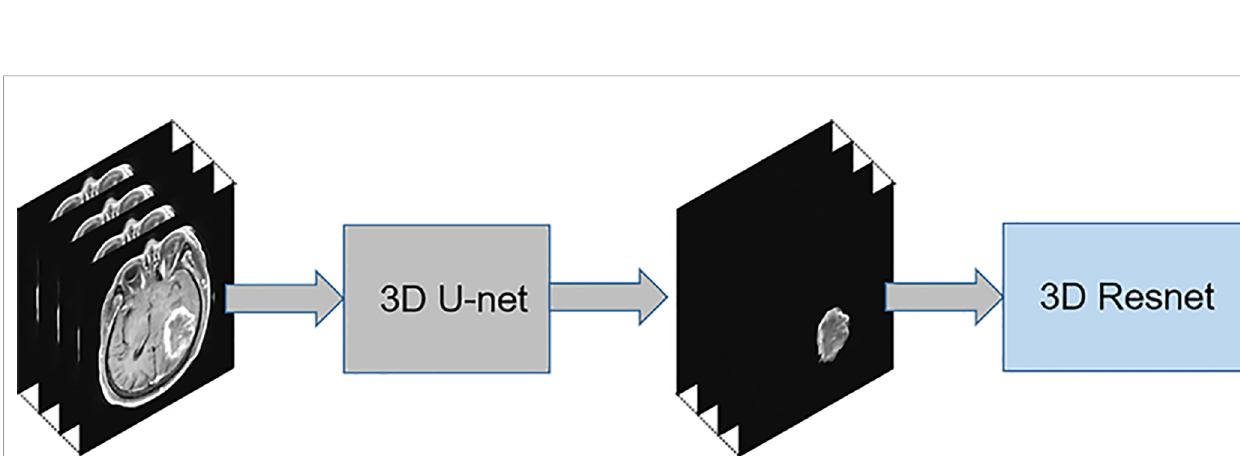
FIGURE 2 | Enhanced data with different k values. The top row represents solitary fi gures, and the bottom row represents multiple lesions. k is − 0.5 (A) , 0 (B) , 0.5 (C) , 1 (D) , and 2 (E) .